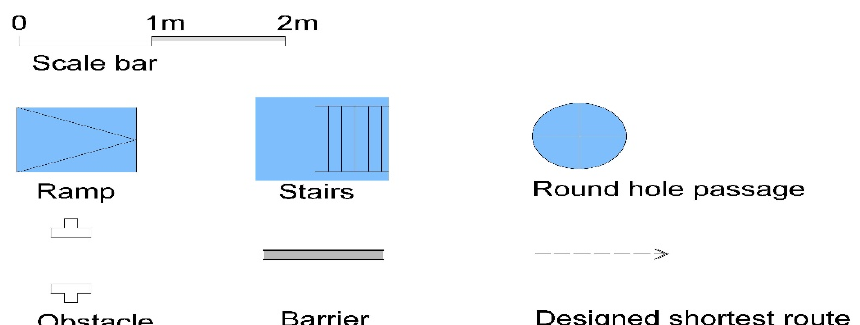
Figure 2. Legends for the floor plans.